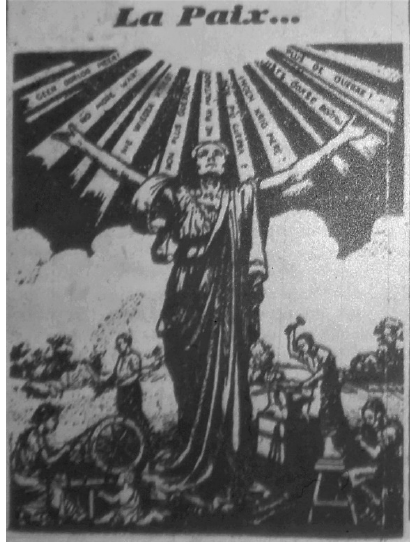
Figure 8. “Open Your Hearts.” La Patrie Humaine. 25 March 1933. Ink on Paper. Bibliothèque Nationale